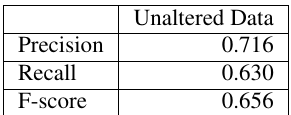
Table 1. Recall, Precision and F-score of the segmentation results when using unaltered data for the predictions Table 2 shows the percentage difference of the recall values in comparison to the recall values of the original data. By ob- serving the recall we can look at the proportion of actual pos- itives that have been identified correctly. According to our res- Figure 2. The images are altered to compare the segmentation results in the next step. Due to space limitations, not all possbile combinations are shown.